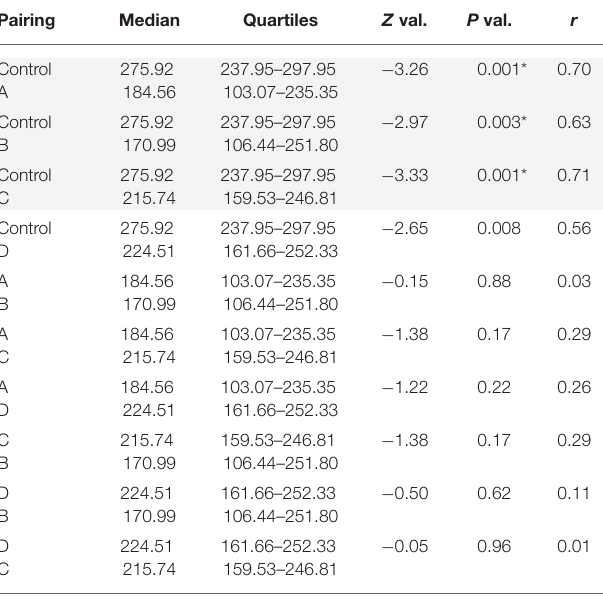
TABLE 5 | Wilcoxon signed-rank test—interest and enjoyment scores.